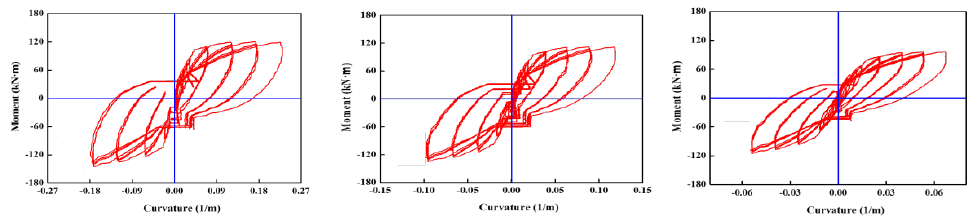
( e ) PPECC-5: 15 cm (left); 30 cm (middle); 60 cm (right)